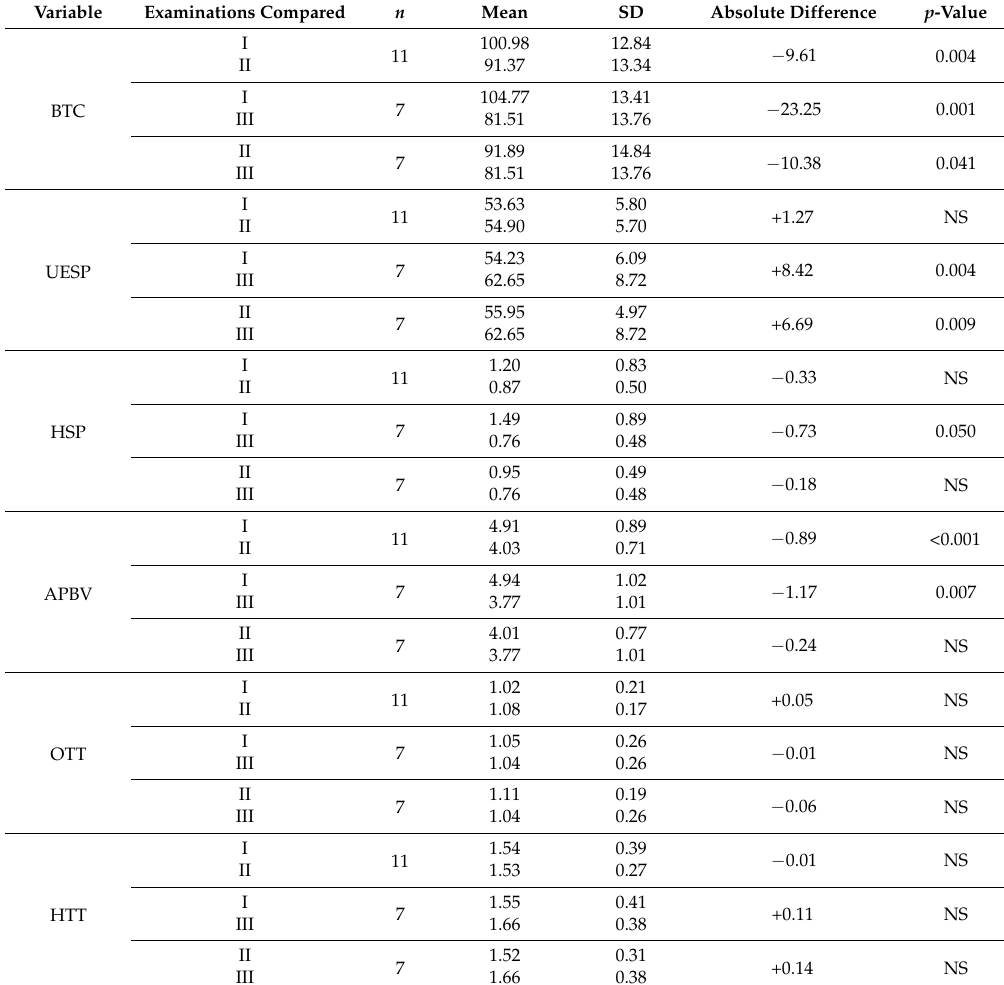
Table 4. Progression of swallowing difficulties among patients with amyotrophic lateral sclerosis— wet swallowing.